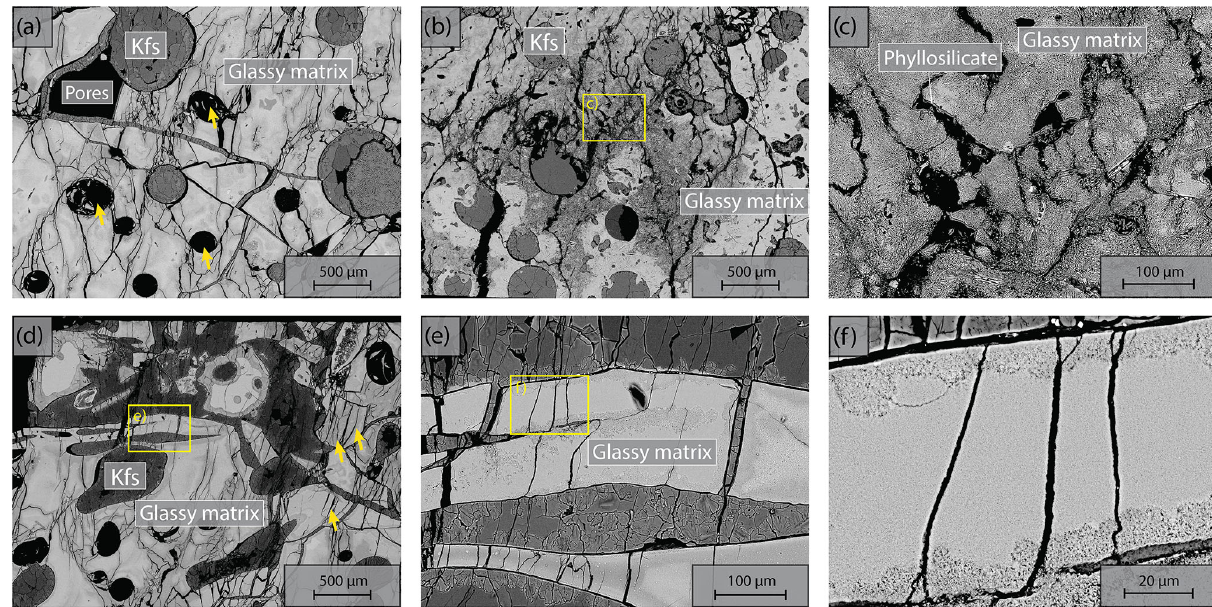
Figure 12. Microstructures of deformed sample from the H 2 O + CO 2 open experiment (OR3_B). Axial view, loading from top and bottom. (a) Pervasively fractured matrix; note the preferential N–S alignment of cracks indicating that most cracks are Mode I. Note the collapse of void pores with cracks emanating (arrows). (b) Crack pattern in altered glass matrix. (c) Close-up of (b) . Note the phyllosilicate coating on the crack wall. (d–f) Magnification cascade illustrating the crack shape and morphology in the deformed